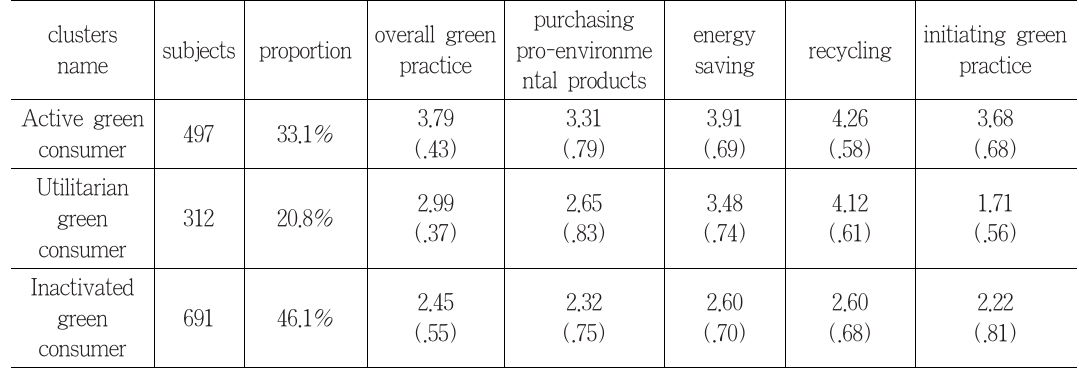
<Table 3> Green Consumer Clusters and Practices of Green